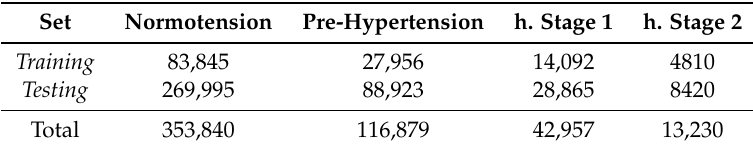
Table 1. Description of the data set used in this study.